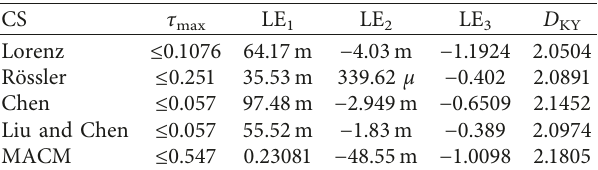
Table 5: Analysis of chaos degradation for DV of 3D CSs by using the NA of RK4 (9)–(13).